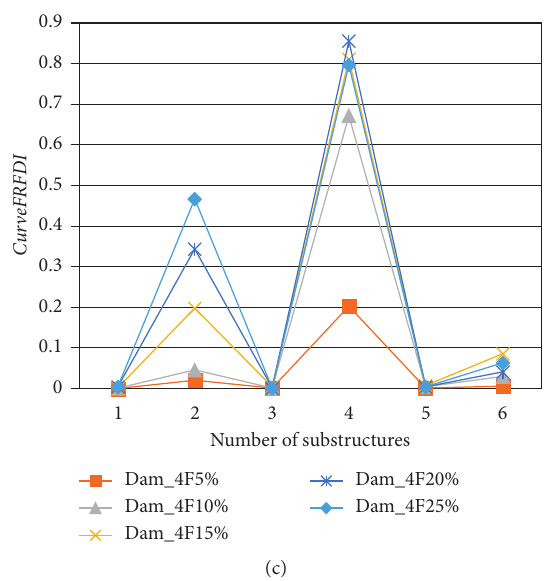
Figure 19: The comparison of the CurveFRFDI for 5%, 10%, 15%, 20%, and 25% stiffness reduction in (a) the 2 nd floor, (b) the 3 rd floor, and (c) the 4 th floor.